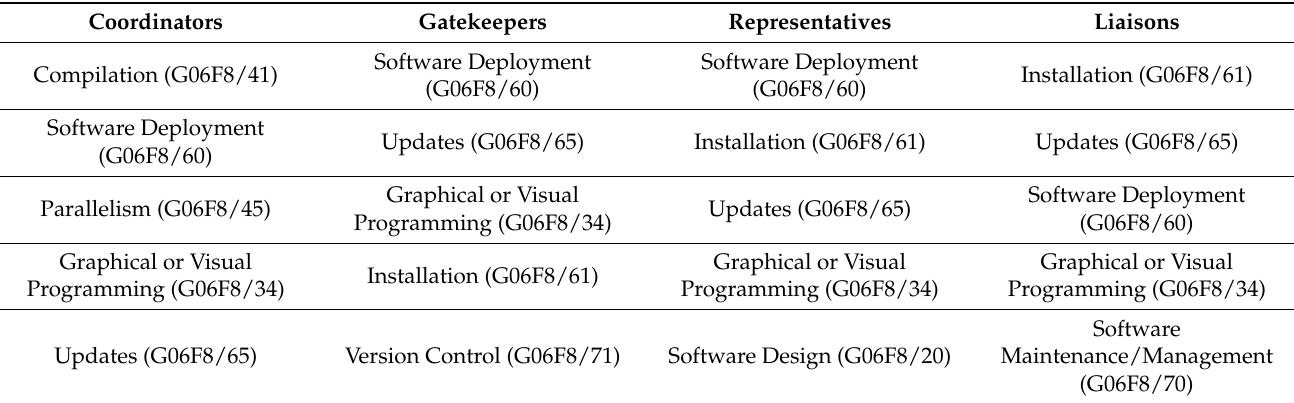
Table 9. Top brokers in each